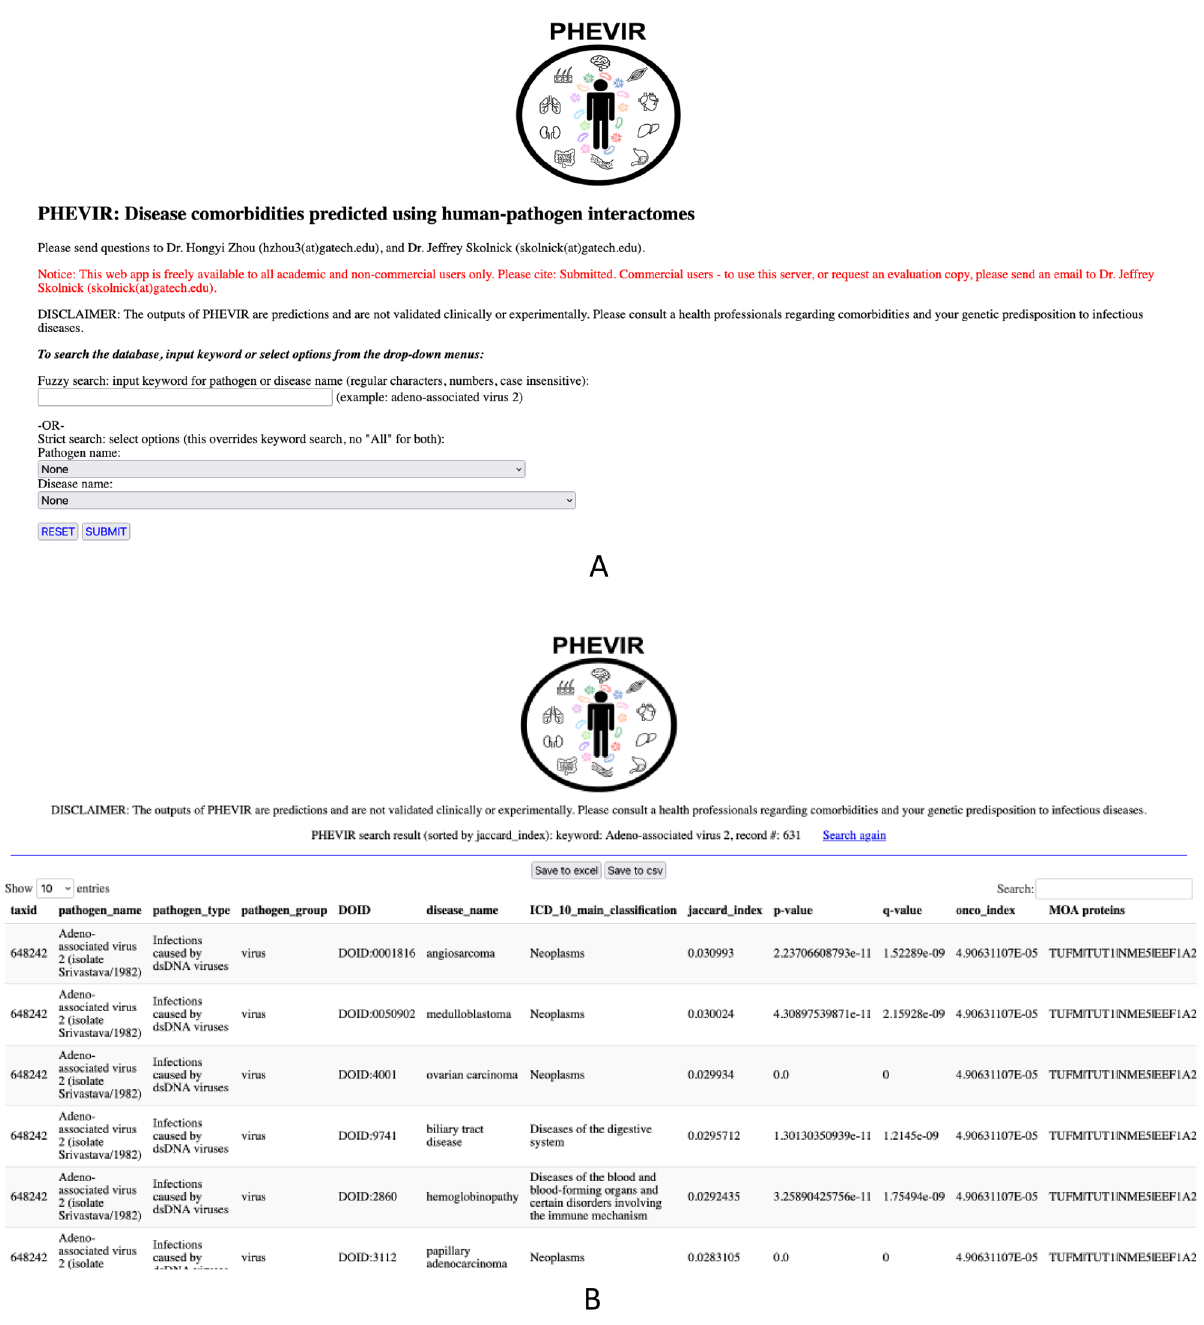
Figure 1. Screenshots of PHEVIR webserver. ( A ) Web interface of PHEVIR. ( B ) Sample output of